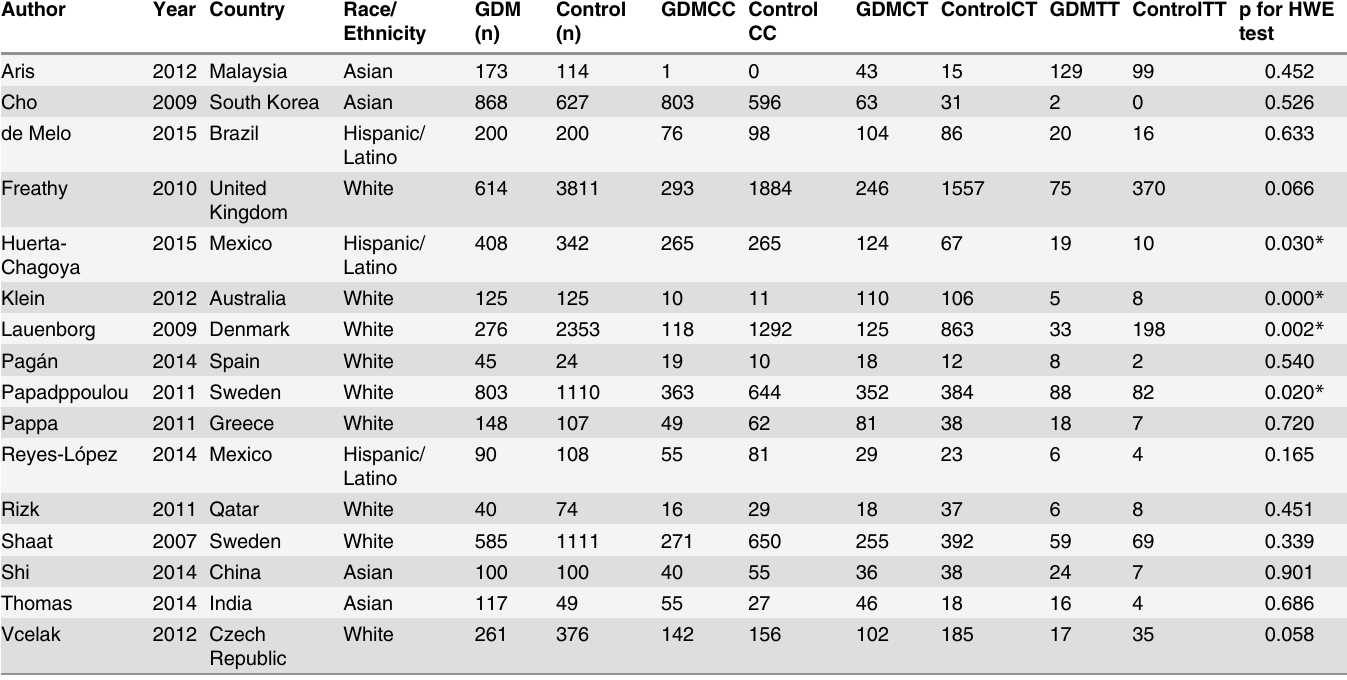
Table 2. Study countries, racial/ethnic categories, sample sizes, and genotype frequencies of TCF7L2 rs7903146 polymorphism of studies